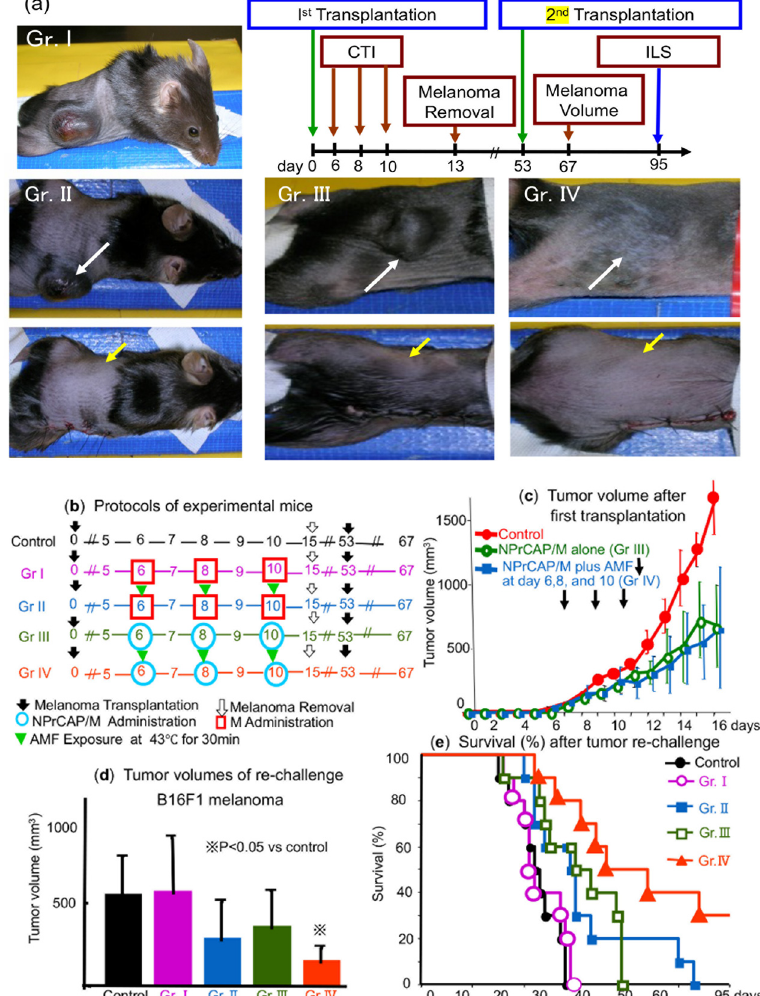
Figure 7. ( a ) Experimental operation processes with mice showing the growth inhibition of re-challenged melanoma (second transplantation) after removal of NPrCAP/M-treated melanoma (first transplantation) through immune processes. Control, non-treated; Gr. I, magnetite alone (no NPrCAP, no heat); Gr. II: Magnetite alone without NPrCAP, but with 43 °C heat for 30 min by AMF exposure; Gr. III: NPrCAP/M treatment, but no AMF exposure; Gr. IV: mouse with both NPrCAP/M and AMF exposure. After removal of the first transplant, all mice received the second re-challenge melanoma transplantation. White arrows, the site transplanted with melanoma at first transplantation; yellow arrows, the site transplanted with rechallenged melanoma at second transplantation. Tumor volume was measured at day 67 and representative photos are shown. ILS: Increased lifespan. CTI: Chemo-thermo-immuno-therapy. Adapted from [45]. ( b ) Treatment protocols for the 4 groups of mice described in ( a ) and an untreated control group. After primary B16F1 melanoma transplantations on day 0, treatments with magnetite nanoparticles with/without NPrCAP and with/without AMF exposure were administered on days 6, 8, and 10, tumors were removed on day 13, and second, re-challenge B16F1 melanomas were transplanted on day 53. ( c ) Daily increases in primary tumor volumes (mm 3 ) after transplantation in control, Gr III, and Gr IV mice. ( d ) Tumor volumes (mm 3 ) of re-challenge melanomas two weeks after transplantation on day 53, after primary B16F1 transplantations, treatments, and removal of primary tumors, as described in ( b ). ( e ) Kaplan–Meier survival curves of experimental mice up to 90 days after tumor re-challenge. Adapted from [45].